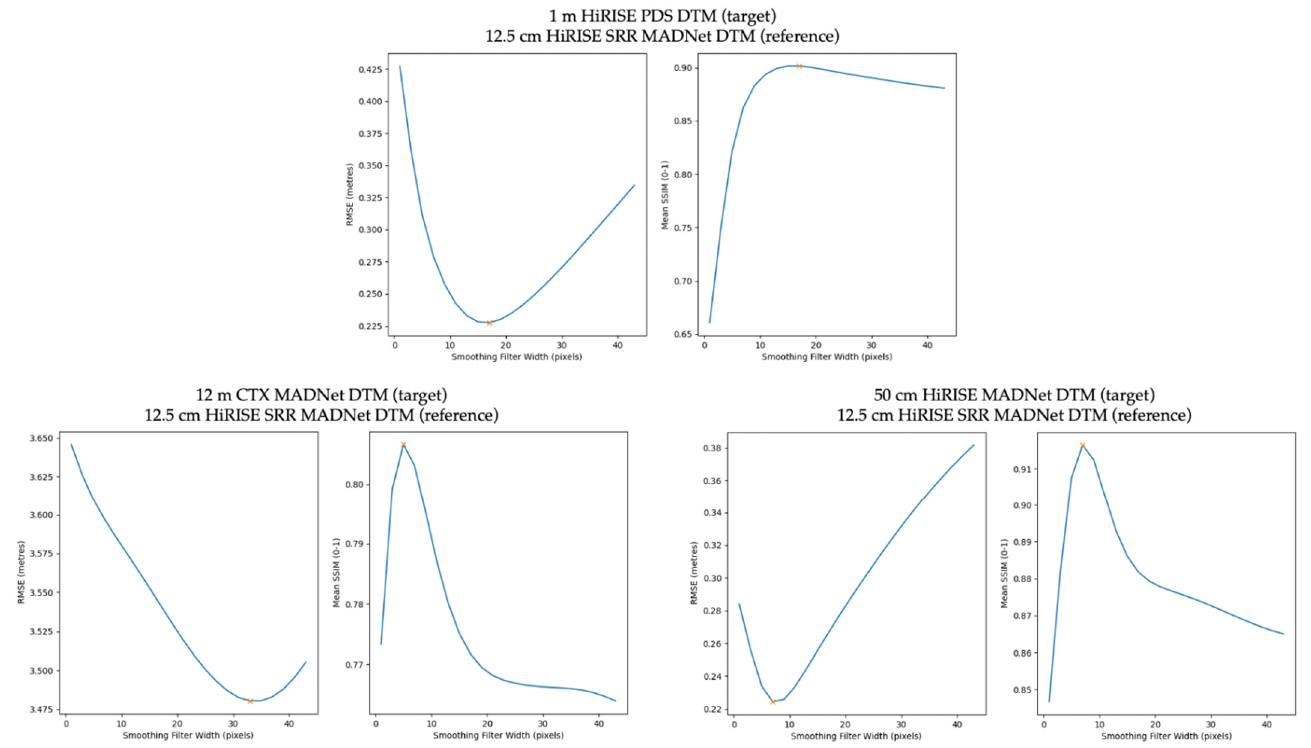
Figure 11. Top: RMSE and SSIM plots of the target 1 m/pixel HiRISE PDS DTM (DTEEC_039299_1985_047501_1985_L01) and the reference 12.5 cm/pixel HiRISE SRR MADNet DTM; Bottom-left: RMSE and SSIM plots of the target 12 m/pixel CTX MADNet DTM [28] and the reference 12.5 cm/pixel HiRISE SRR MADNet DTM; Bottom-right: RMSE and SSIM plots of the target 50 cm/pixel HiRISE MADNet DTM [28] and the reference 12.5 cm/pixel HiRISE SRR MADNet DTM.